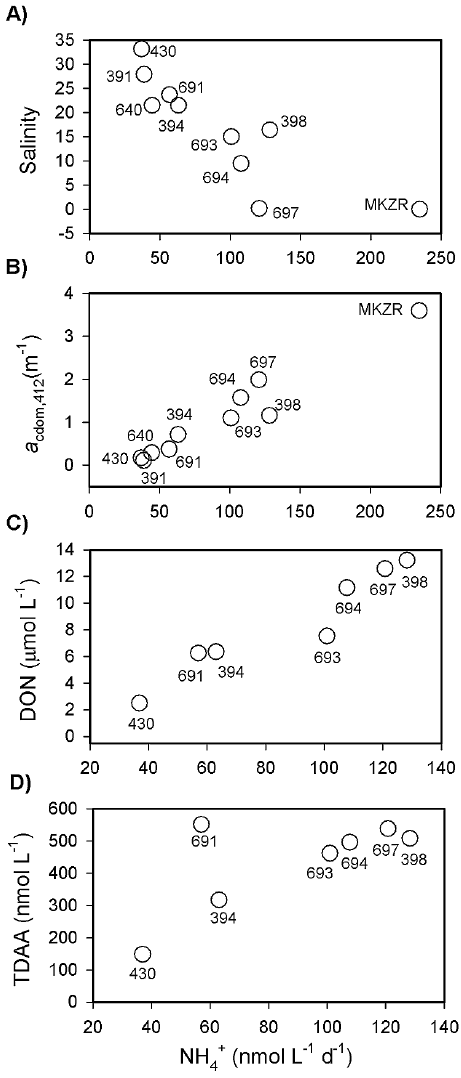
Fig. 5. Plots of ammonium photoproduction rate vs. salinity (A) , CDOM absorption coefficient (B) , dissolved organic nitrogen (C) , and total dissolved amino acids (D) . Data labels represent station numbers and MKZR denotes the June 2009 sample collected in the Mackenzie River near Inuvik (see Sect. 2.5). No DON and TDAA data are available for the MKZR station. NH + photoproduction 4 rates were determined under cutoff filter